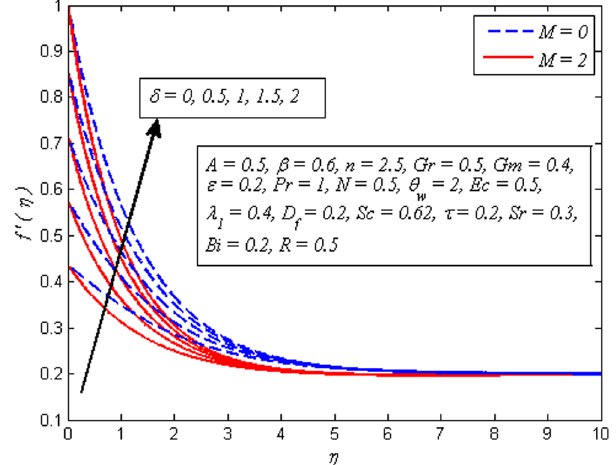
Figure 9. Effect of δ on velocity for different values of M